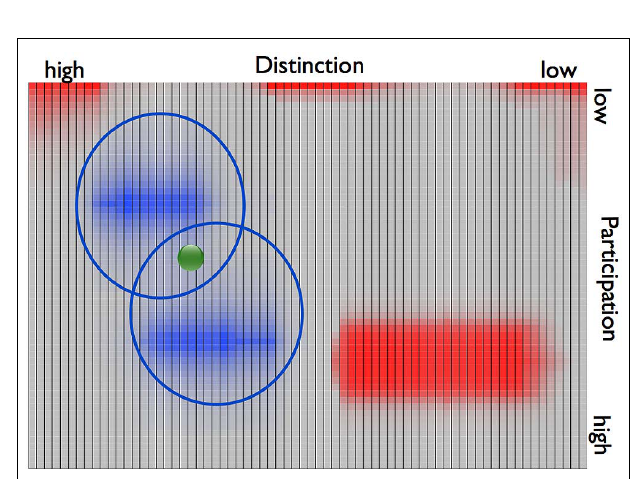
FIGURE 7 | 2D plane view on the dyadic phase space of example 2. The two attractor regions are depicted in blue, the repellors in red.The attractors are circled.Their intersection represents the saddle region in which the dyad’s state (green ball)